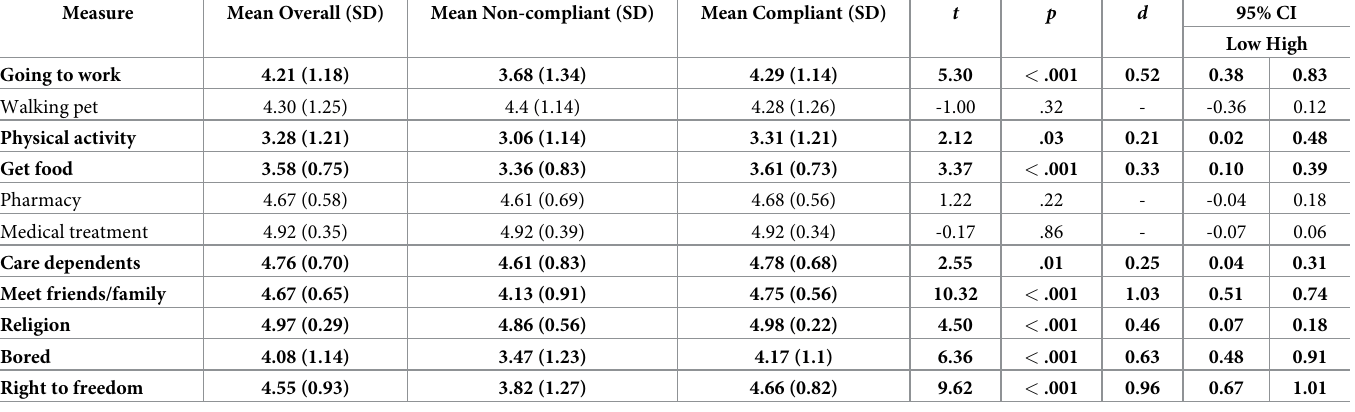
Table 8. Series of t-tests on the difference between classes on future behaviours (df = 938).